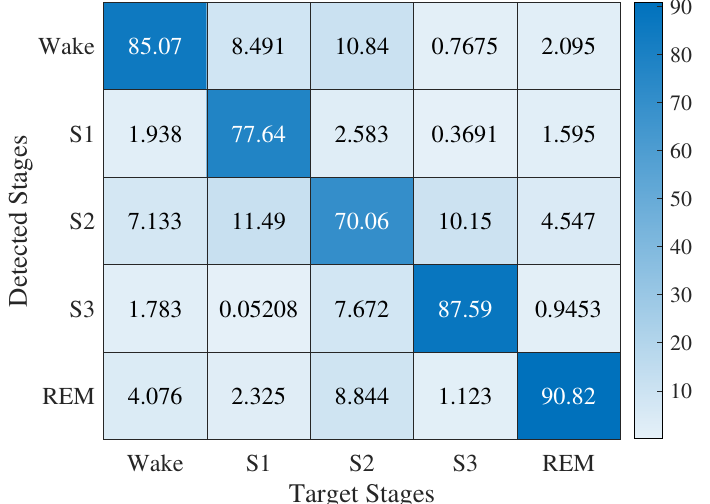
Figure 5. SVM classification baseline performance due to all HRV features for micro-labeled sleep stages.